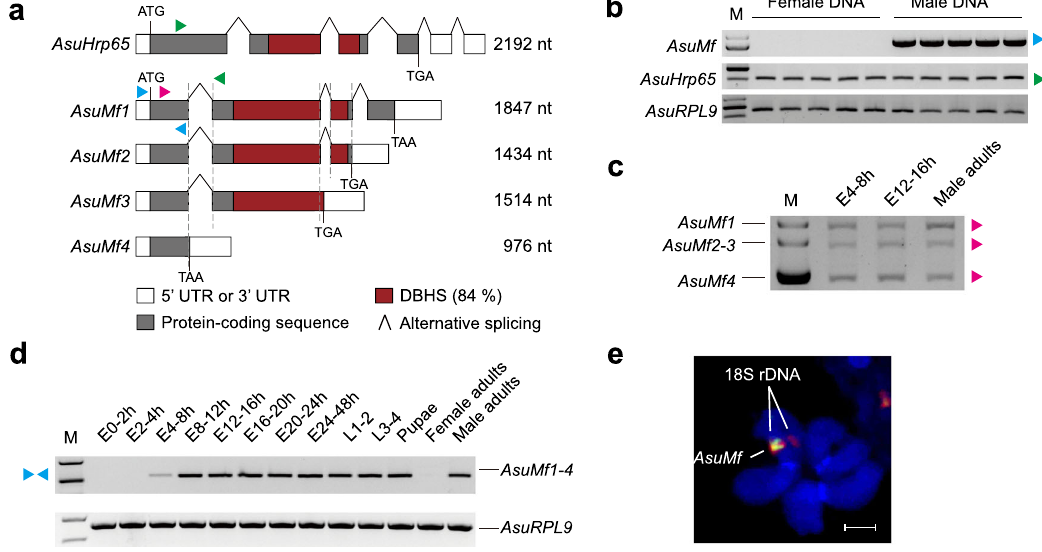
Fig. 1 | AsuMf is a male-speci fi c gene belonging to the DBHS gene family. a Schematic comparisons of the conceptual translation products of AsuHrp65 and AsuMf1 - 4 isoforms. Lengths in nucleotides (nt) are listed to the right of each iso- form. White boxes are 5 ’ - and 3 ’ -end non-transcribed regions. Gray boxes are the coding sequences and those in the cinnamon-colored boxes represent the DHBS domains.ThenucleotideidentityoftheDBHSdomainisindicatedasapercentage. Oligonucleotideprimerlocationsanddirections:greentriangle,AsuHrp65F/R;Blue triangle, AsuMfF/R; Pink triangle, AsuMf 3 ’ RACE inner (Table S5). b Genomic ampli fi cations with paralog-speci fi c primers complementary to exon1 show that AsuMf gene sequences are present only in males. The paralog, AsuHrp65 ,